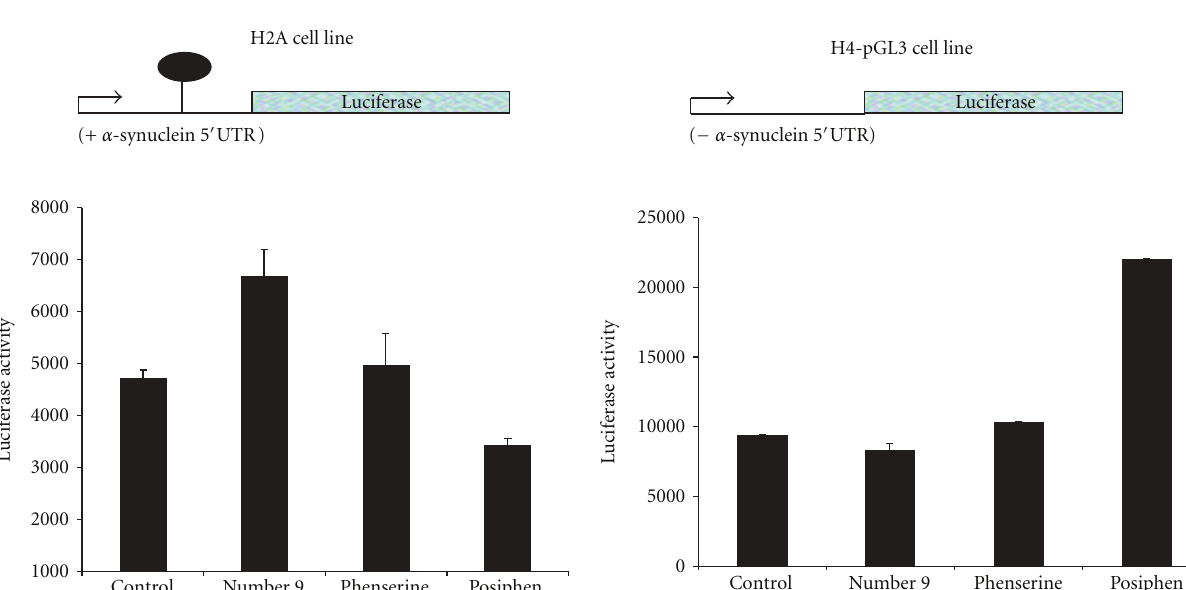
Figure 4: Selectivity of posiphen to inhibit translation driven by alpha-synuclein 5 (cid:2) UTR sequences: a second set of transient transfection experiments in which posiphen (10 μ M) selectively inhibited alpha-synuclein 5 (cid:2) UTR-conferred luciferase expression in SH-SY5Y neural cells ( SNCA 5 (cid:2) UTR-positive transfectants, ( N = 6)). Confirming selectivity, posiphen increased luciferase expression in pGL3-transfected SH- SY5Y cells ( ∗∗ pGL3-SH-SY5Y serves as an experimental control since these cells were transfected with pGL3, which is the same as the H2A construct but lacks the α -synuclein 5 (cid:2) UTR).